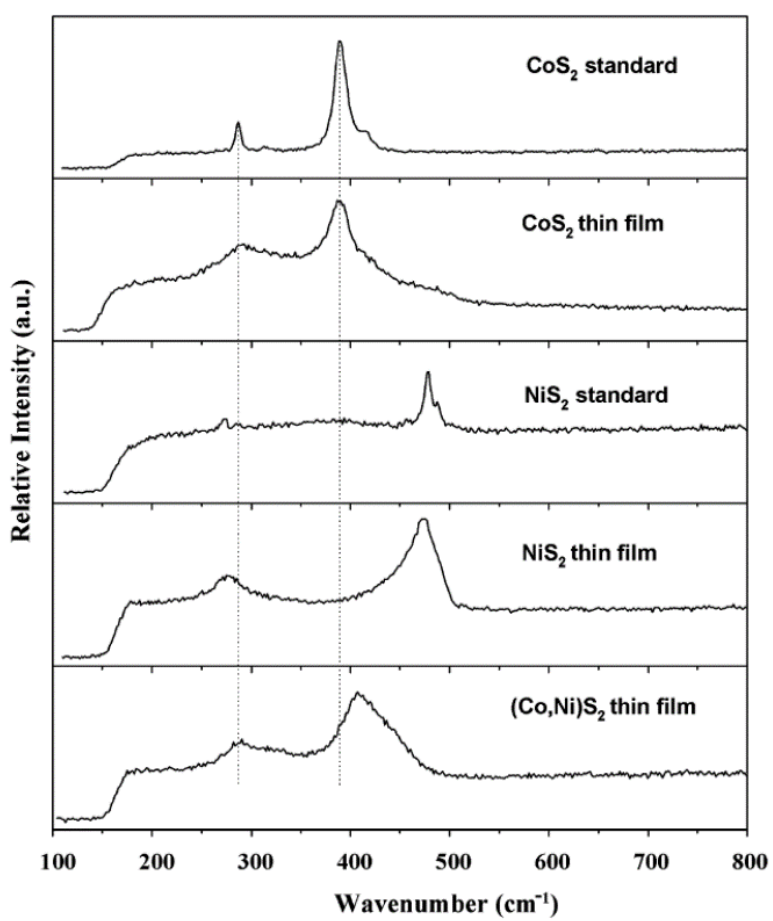
Figure 27. Raman spectra measured with HeNe laser for the CoS 2 , NiS 2 and (Co,Ni)S 2 thin films and compared with those measured for standard CoS 2 and NiS 2 samples. Reproduced with permission from [112].